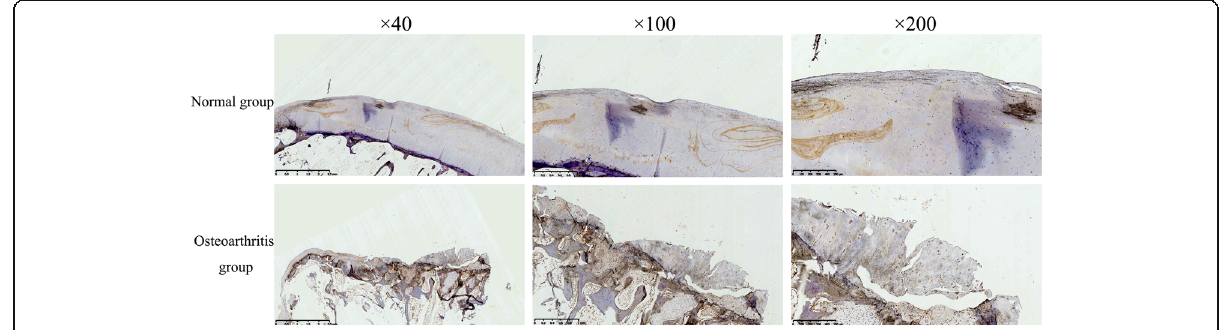
Fig. 5 The NDRG3 staining of the cartilage in the normal group and osteoarthritis group